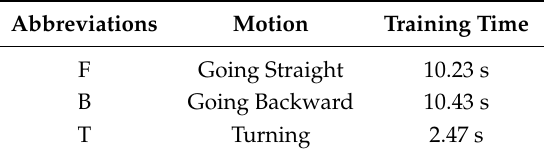
Table 1. The motion information of